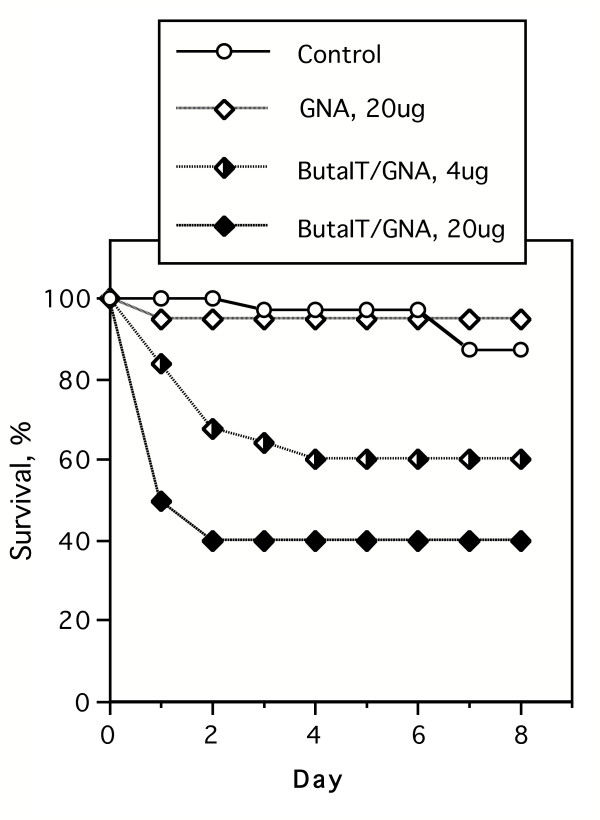
Survival of L. oleracea larvae following injection of purified recombinant proteins. Survival was recorded for fifth stadium L. oleracea larvae following injections of recombinant GNA or ButaIT/GNA. Control insects were injected with phosphate buffered saline (PBS; n = 40). GNA was injected at a dose of 20 μg which equates to approx. 500 μg GNA/g insect (n = 20); ButaIT/GNA was injected at two different concentrations; 4 μg which equates to approx. 100 μg fusion protein or 30 μg toxin/g insect (n = 25), and 20 μg which equates to approx. 450 μg of fusion protein or 135 μg toxin/g insect (n = 10).